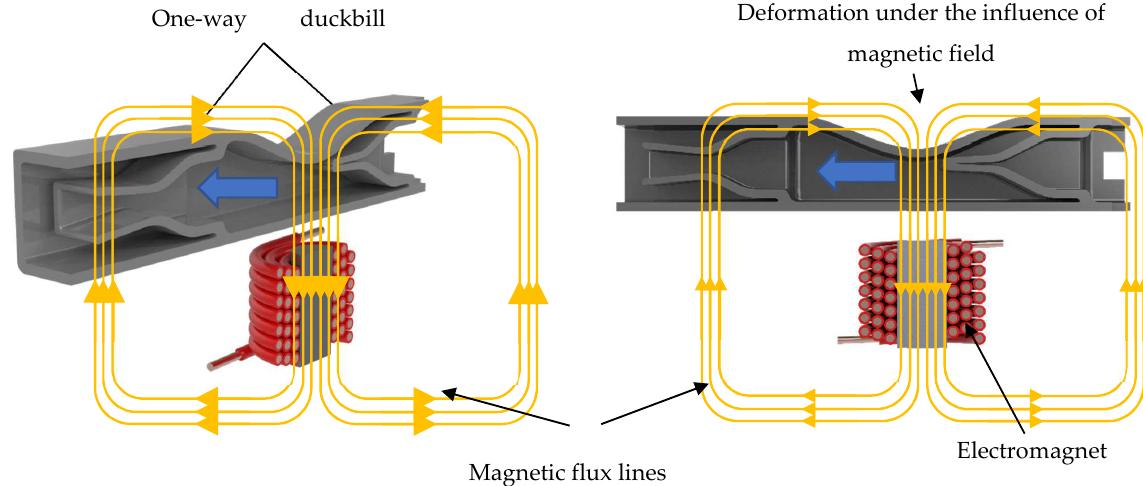
Figure 1. The proposed micropump design with its main